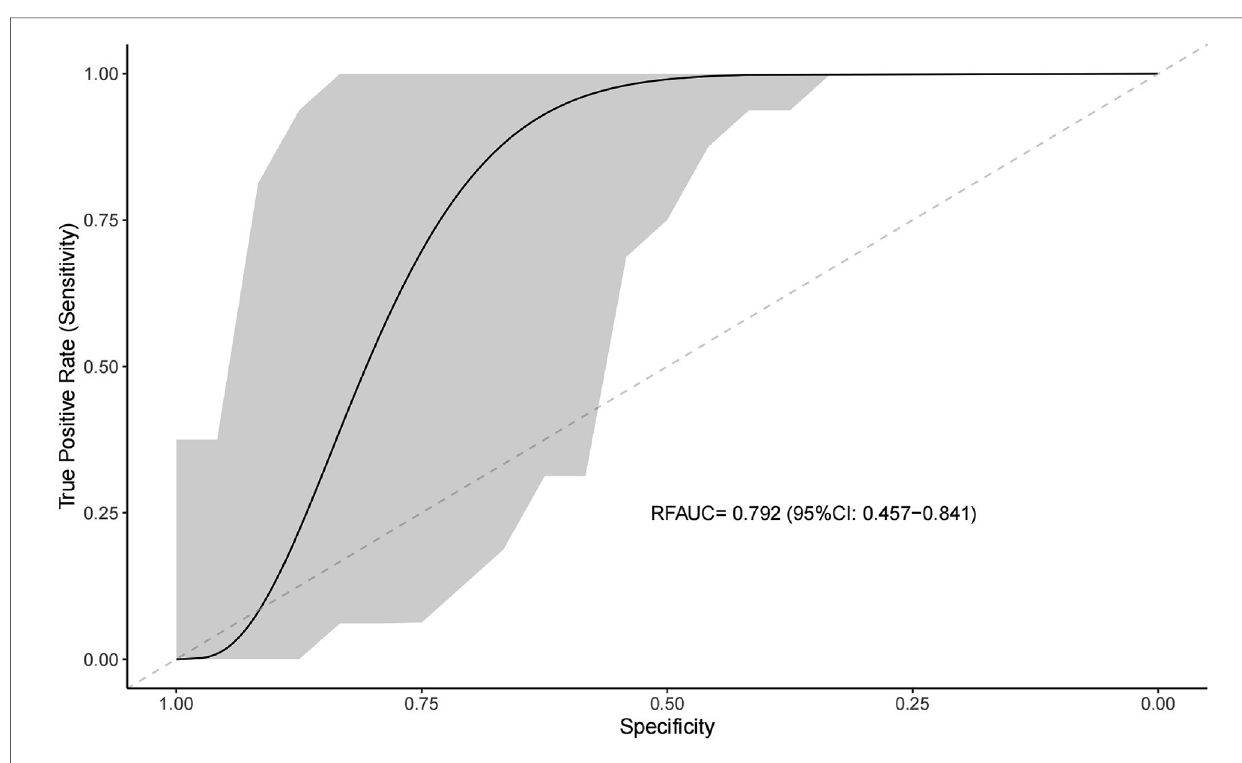
FIGURE 2 Receiver operating characteristic curve for evaluating the predictive ability of the machine learning